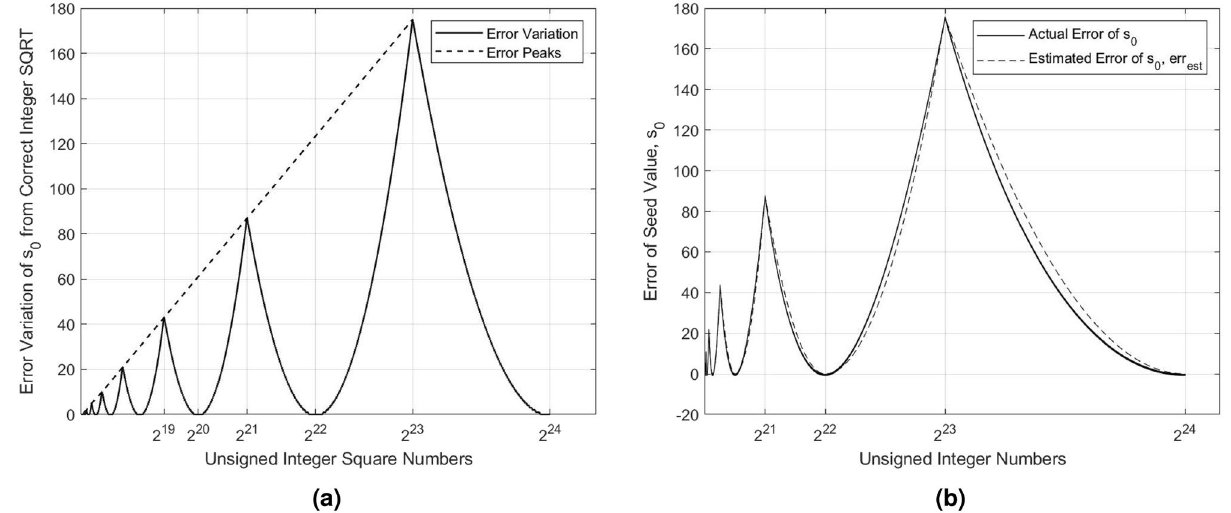
Figure 1. Generated error from seed estimation s 0 : ( a ) A scaled plot showing the pattern of the error of s 0 , as it varies from the correct integer square root. Peaks of the error increase linearly, whereas the shape between consecutive error peaks forms a parabola-like curve (PLC). ( b ) Variations of the actual and estimated errors of the generated seed value, s 0